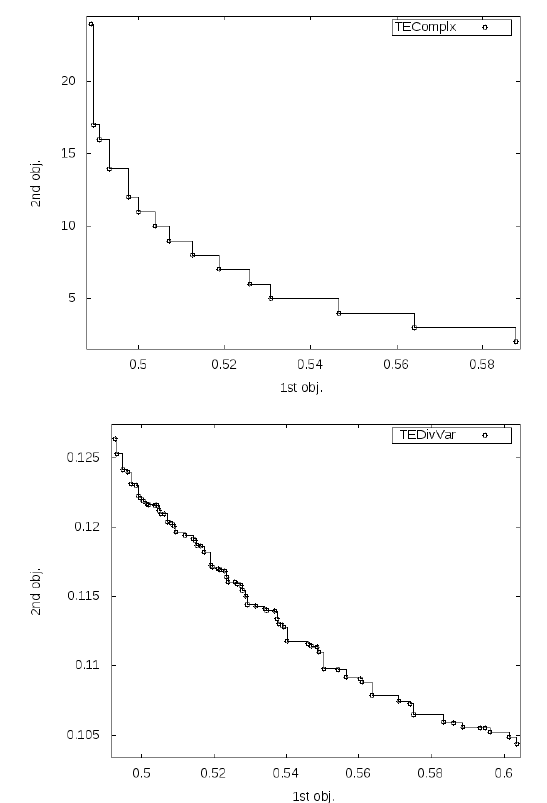
Fig. 3. The Pareto front approximation obtained for abalone using fitness function 2a (objective 1 stands for training er- ror and objective 2 for complexity) on the top, and fitness function 2b (Objective 1 stands for training error and objec- tive 2 for variance) on the bottom.